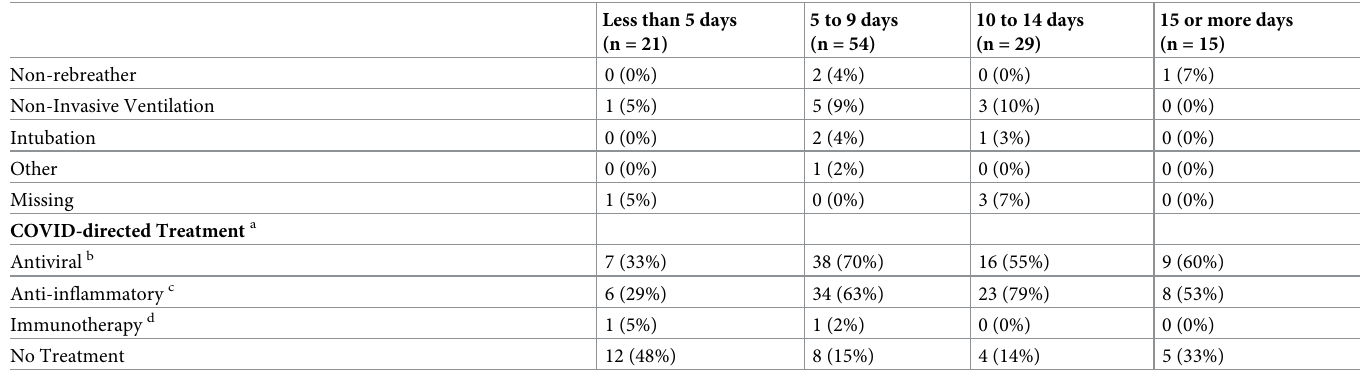
be statistically estimated with fewer specimens included in the longitudinal analysis (Fig 6C). Kaplan-Meier survival curves for saliva specimens and nasal swabs (Fig 7), and log-rank test indicate that the survival curve for saliva specimens is significantly different from the curve for nasal swabs (p = 0.0007). The median survival time for positive nasal swabs was 13 days, whereas the median survival time for positive saliva specimens was 18 days (Fig 7). The proba- bility of saliva yielding a positive test result remained greater than that of nasal swabs at 10 days (saliva survival probability = 0.89 [95% CI = 0.77–1.00] vs nasal swab survival probabil- ity = 0.64 [95% CI = 0.48–0.85]) and 15 days (saliva survival probability = 0.65